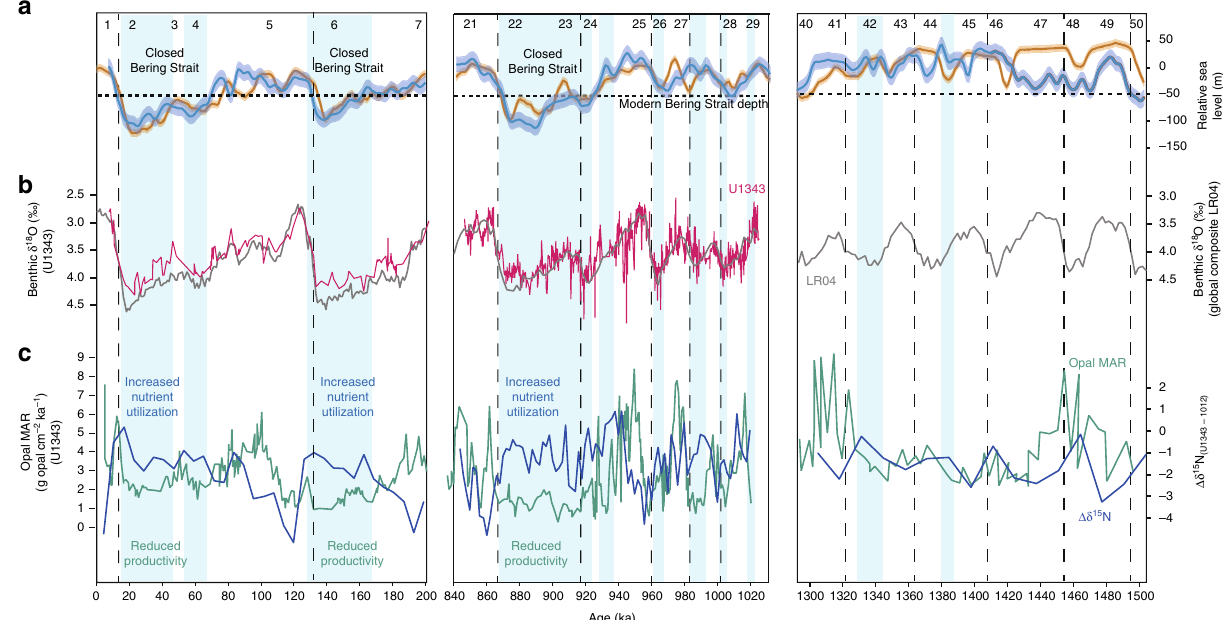
Fig. 5 Proxy data from Site U1343 compared with sea level, for three time periods over the past 1.5 Ma. Vertical blue bars are times of reduced productivity and elevated nutrient utilization indicating reduced deep water nutrient upwelling along the Bering Slope. a Global sea level estimates from Site 1123 (blue) 2 and the Mediterranean (orange) 3 . The current Bering Strait sill depth is indicated with a horizontal dashed line. b Benthic δ 18 O data from U1343 (pink) and LR04 (grey) 30 . U1343 δ 18 O data from 850 – 1020 ka are from this study, other data are published elsewhere 33 . c Bulk sediment δ 15 N for Site 1012 48 subtracted from U1343 (blue) ( Δδ 15 N). U1343 δ 15 N data from 850 – 1020 ka are from this study, other are data are published elsewhere 39,68 . Opal mass accumulation rate (MAR) as a proxy for productivity (green) for Site U1343